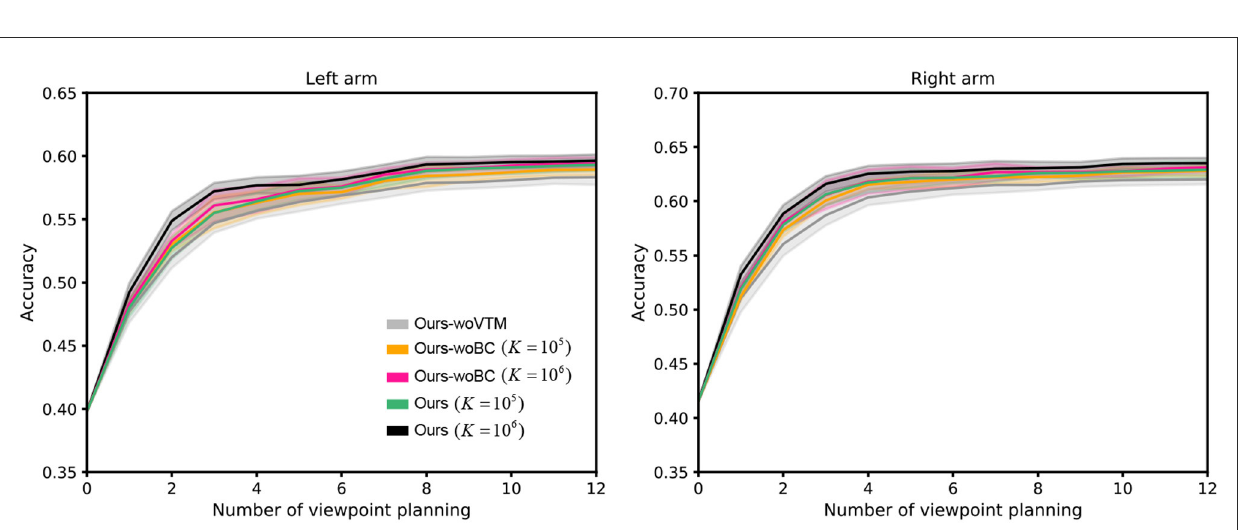
FIGURE8 The performance comparison results of ablation experiments. K represents the capacity of the viewpoint transition buffer. The shaded region represents the standard deviation of the average evaluation over 10